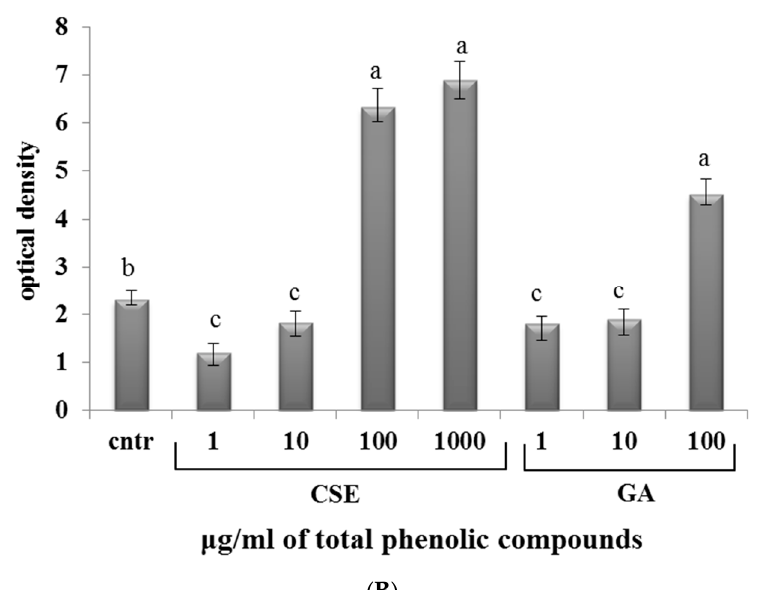
Figure 5. Superoxide anion production in response to different doses of CSE and GA in in vitro incubations of intestinal intraepithelial non-adherent leukocytes ( A ) and blood non-adherent leukocytes ( B ) of rainbow trout. The data represent the mean ± SD of different fish samples ( n = 9). Different letters on the columns indicate statistically significant differences (cntr = control). The concentration reported on the x axis refers to the total phenolic compounds contained in the chestnut shell extract (CSE).